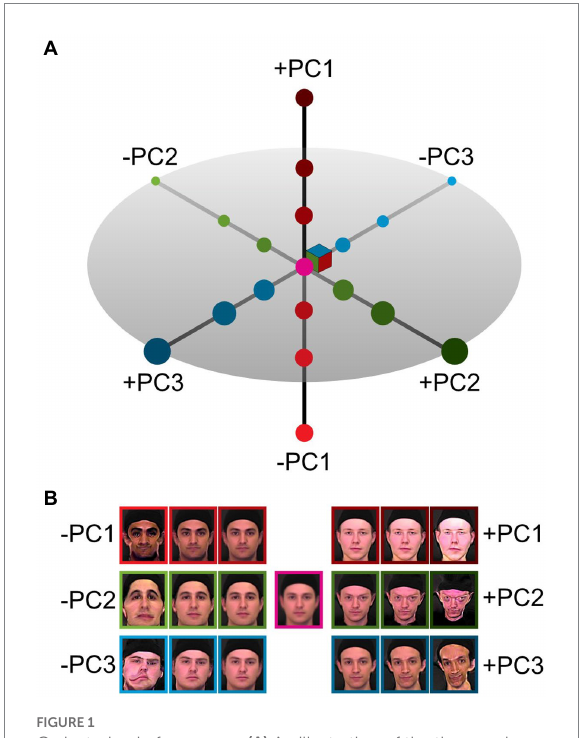
FIGURE 1 Caricaturing in face space. (A) An illustration of the three major axes of a principal component face space constructed from images of male faces. The origin in this space corresponds to the average face. Principal components (PC1 red, PC2 green, PC3 blue) are ordered by variance explained in the underlying data. (B) Example images created by modulating each of the principal components independently. Positive and negative deviations from the origin result in opposing changes in reconstructed images, increasingly caricatured with larger distances from the origin (average face,